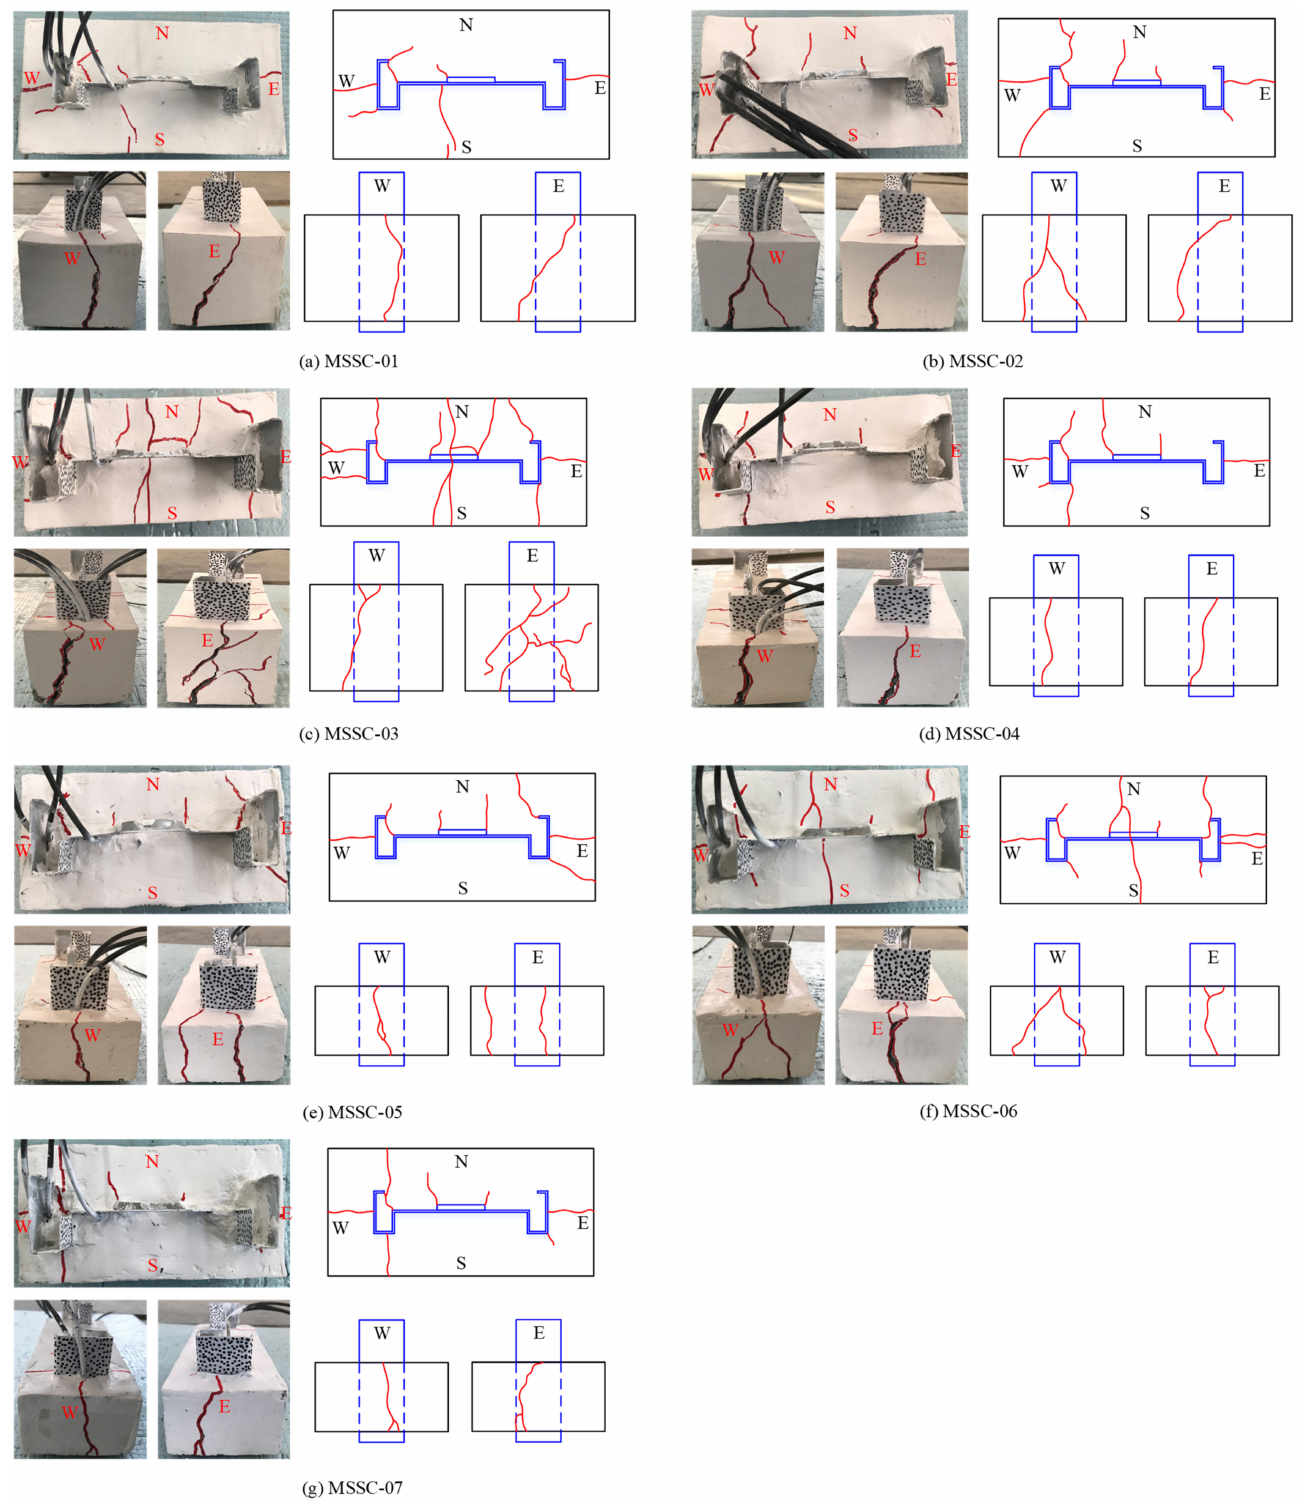
Figure 8. Final failure mode of MSSC